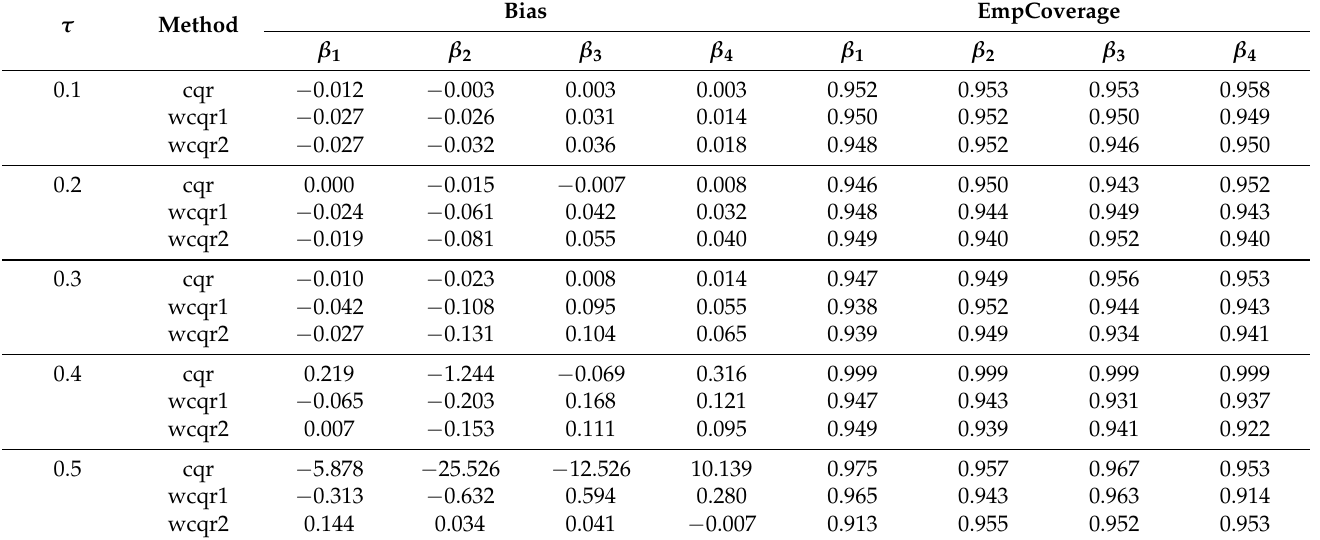
Table 1. Bias and empirical coverage; n = 300, ρ = 0, p 0 = 0.8, p 1 =